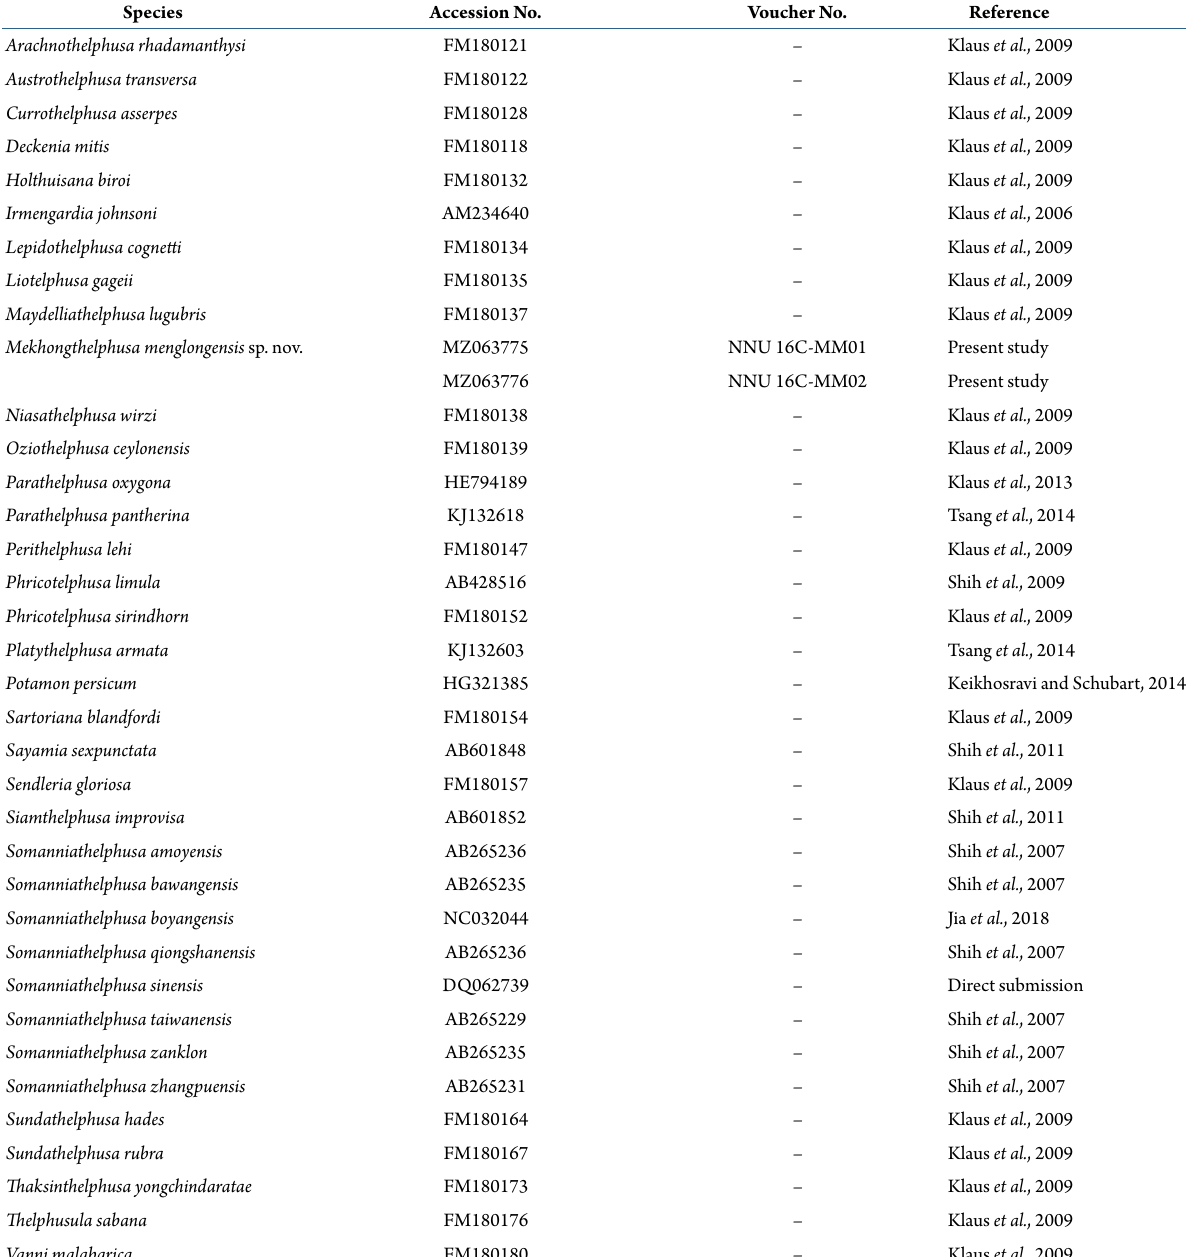
Table 1. 16S rRNA gene sequences used in phylogenetic